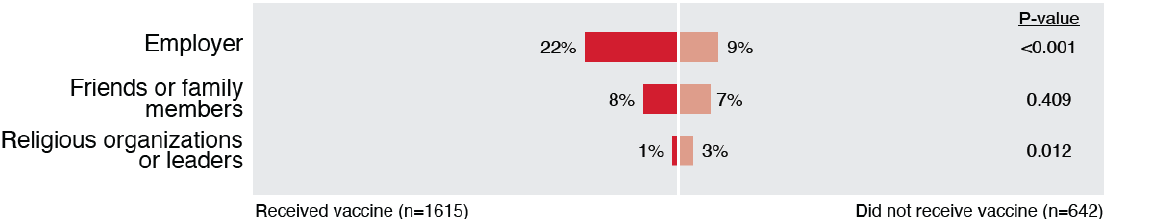
At our agency we were told that getting vaccinated would eliminate the need for a mask. Now that people wearing masks. I feel like there is some manipulation going on and that the "rules of the game" are being changed all the time.